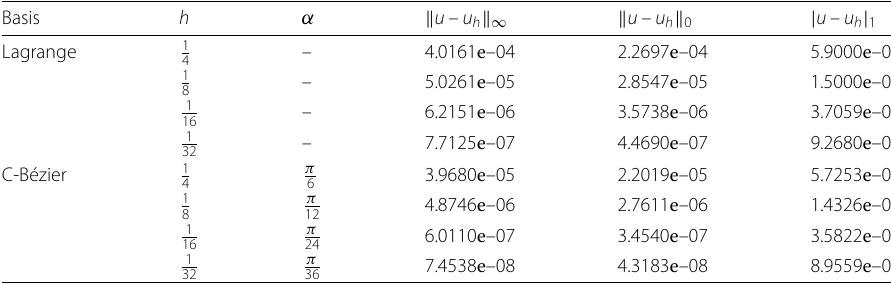
Table 1 The numerical